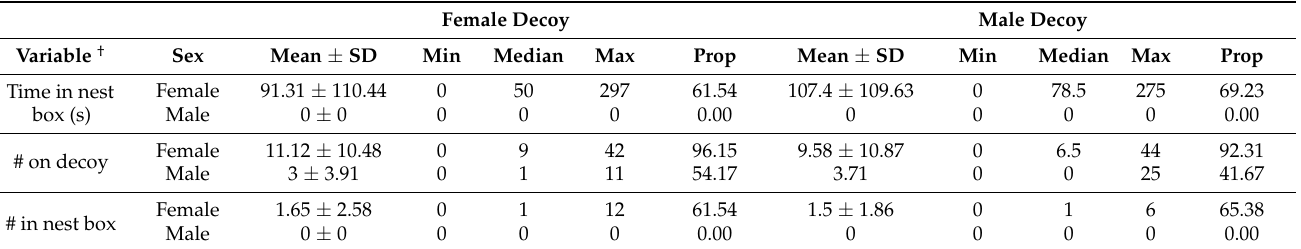
Table A1. Cont. Female Decoy Male Decoy